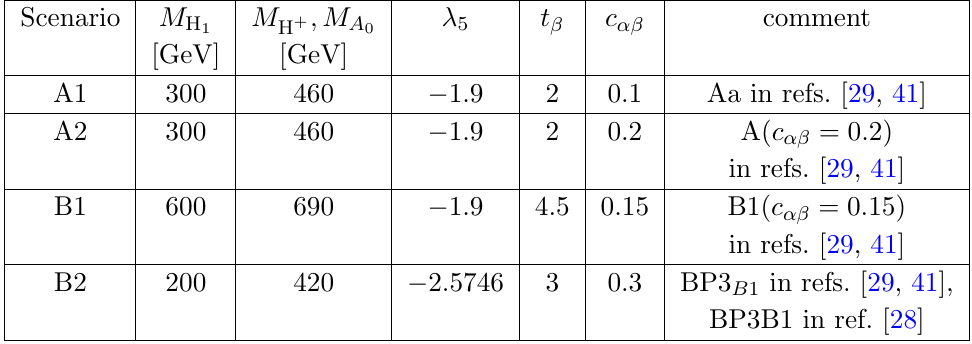
Table 6 . THDM input parameters in the considered scenarios of a THDM of Type I. The light CP-even Higgs boson has mass M H